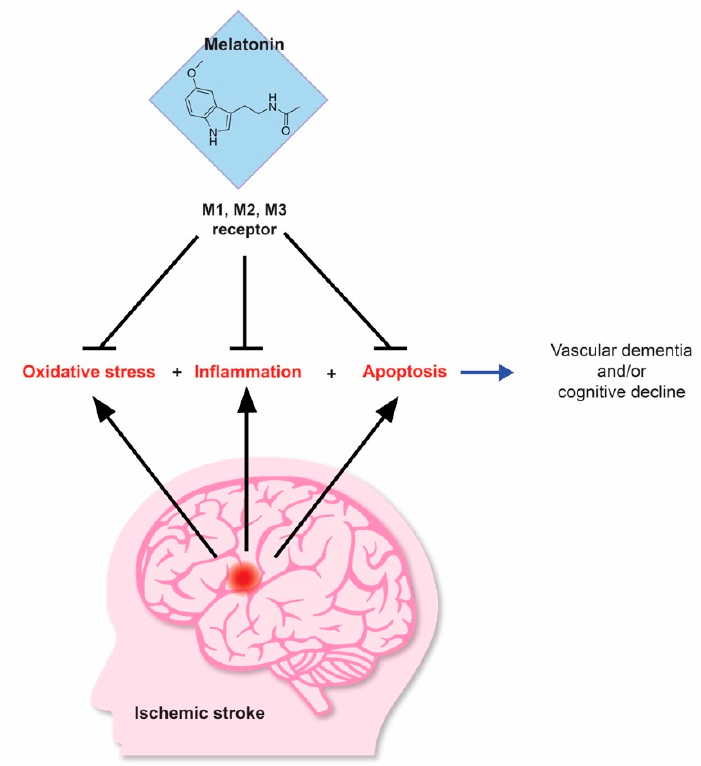
Figure 1. Melatonin’s Neuroprotective Effects. Through the M1, M2 and M3 receptors, Melatonin imparts therapeutic benefits combatting oxidative stress, neuroinflammation and apoptosis induced by ischemic stroke. These neuroprotective traits may also ameliorate vascular dementia and cognitive decline following a stroke.